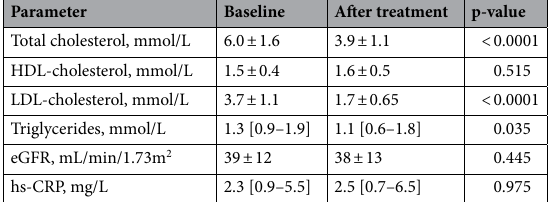
Table 2. Change in lipid and inflammatory